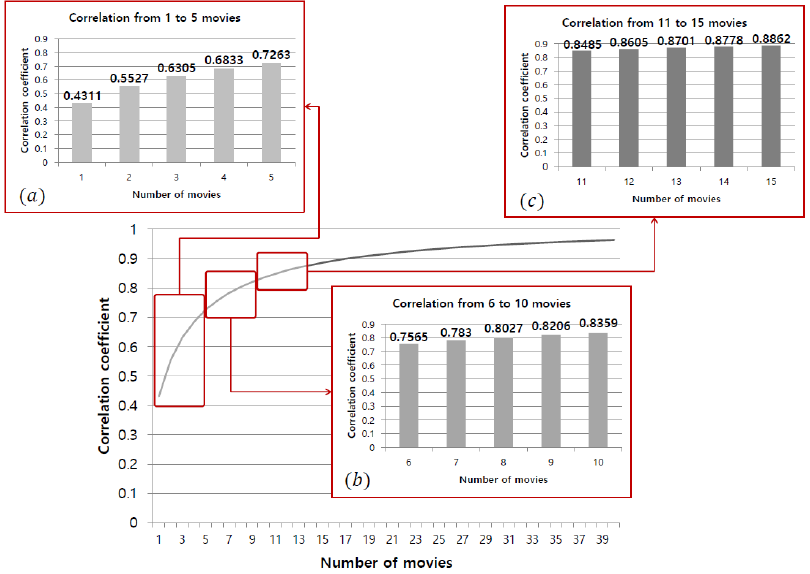
Figure 19. Example of the procedure for calculating the Pearson correlation coefficient.